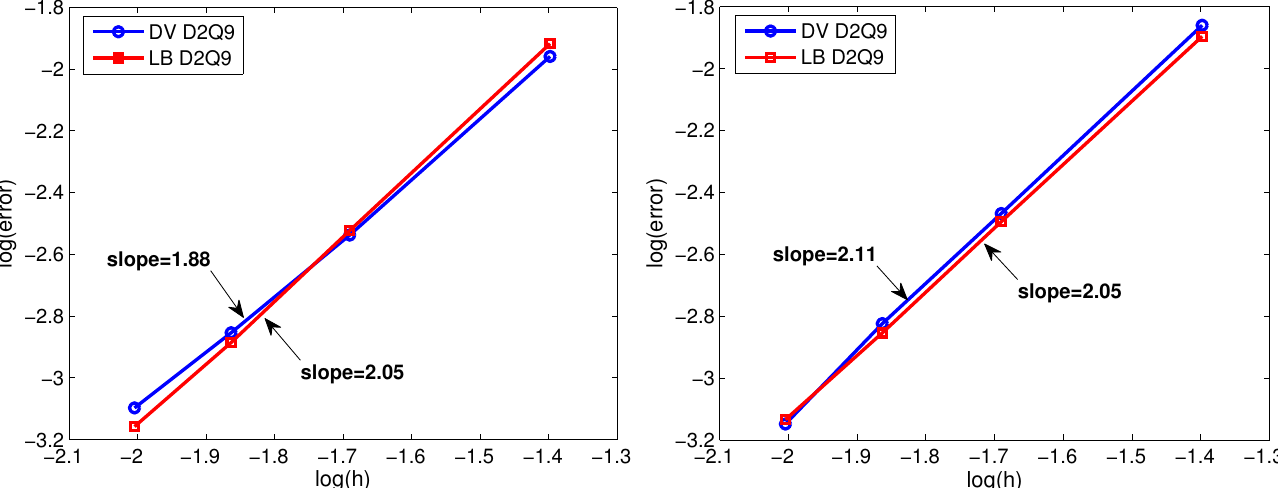
Figure 4. Convergence rates for the shear wave decay and Taylor–Green vortex problems are shown. The results are obtained by applying DV and the conventional LB D 2 Q 9 models. In the ( first slide ) (shear wave decay), the logarithms of the errors (44) for the velocity u x ( y , t ) computed at the moment of time t = 1/ ( ν k 2 ) are presented; in the ( second slide ) (Taylor–Green vortex), the logarithms of the errors of the velocity u x ( x , y = L /2, t ) computed at the moment of time t = 1/ ( 2 ν k 2 ) are presented, where the variable h is proportional to the lattice spacing. The slope estimates are obtained by fitting the values of log ( error ) using the linear